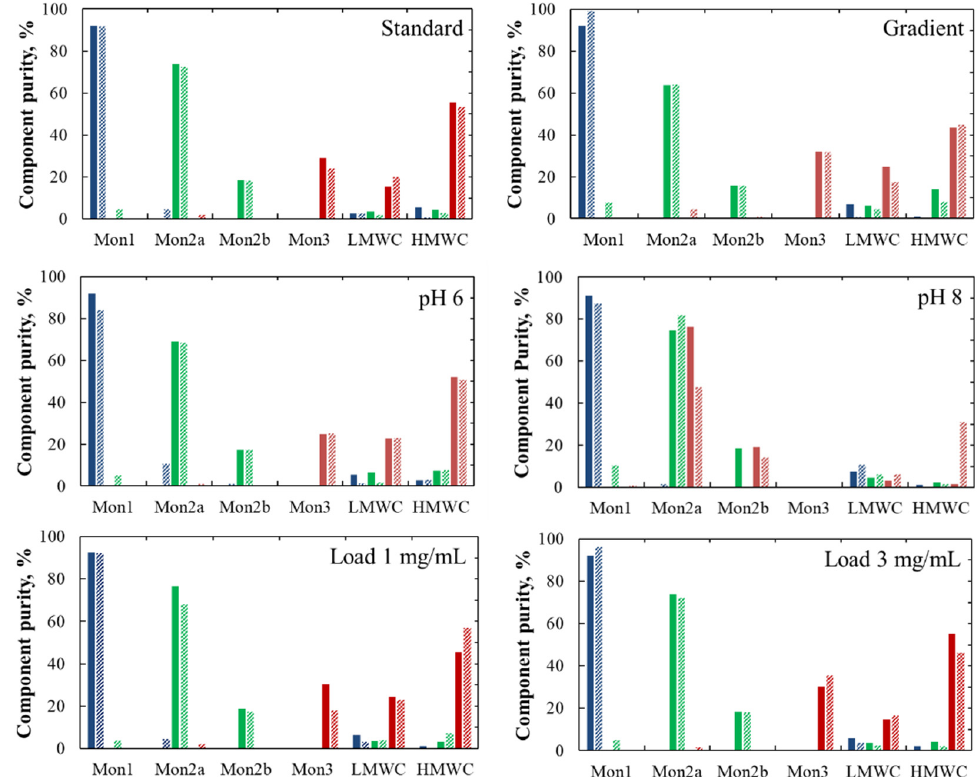
Figure 12. Comparison of experimental (full bars) and simulated (dashed bars) purities of the different components in the three elution peaks of the runs performed. Blue, green, and red bars refer, respectively, to Peak 1, Peak 2, and Peak 3.